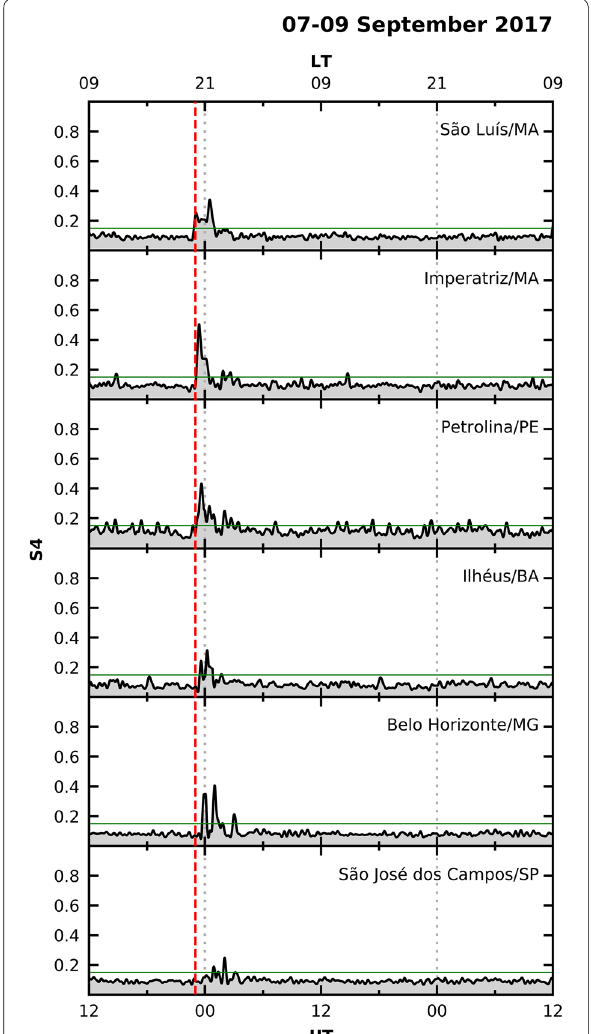
Fig. 8 São Luís PolaRx5 GPS receiver S4 parameters for the frequencies L1, L2C and L5 during the storm period. The green line is the noise threshold, i.e., we consider ionospheric scintillation when S4 > 0.15. The vertical dashed red lines represent the 2 SSCs, the first one at 23:43 UT on day 06 and the second one 23:00 UT on day 07